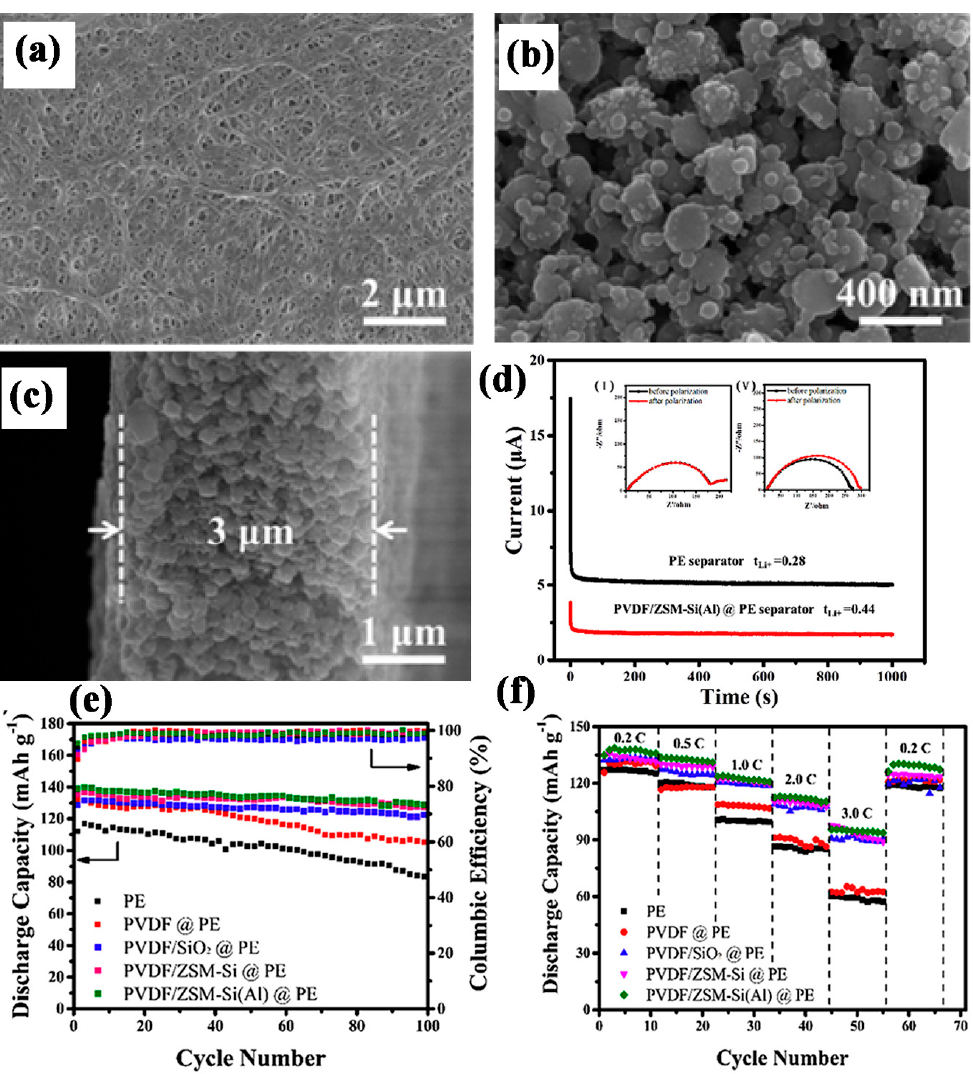
Figure 4. Top view of ( a ) PE ( b ) PVDF/ZSM-Si(Al)@PE ( c ) cross sectional view of